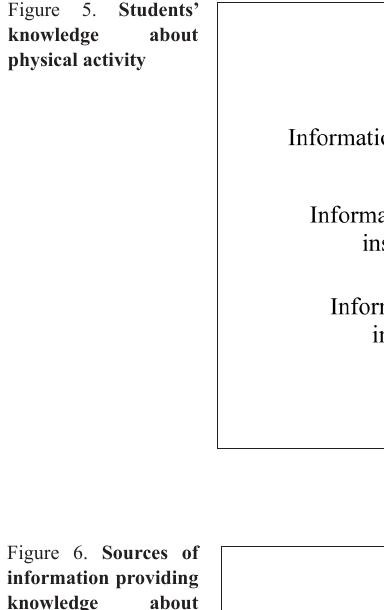
Figure 6. Sources of information